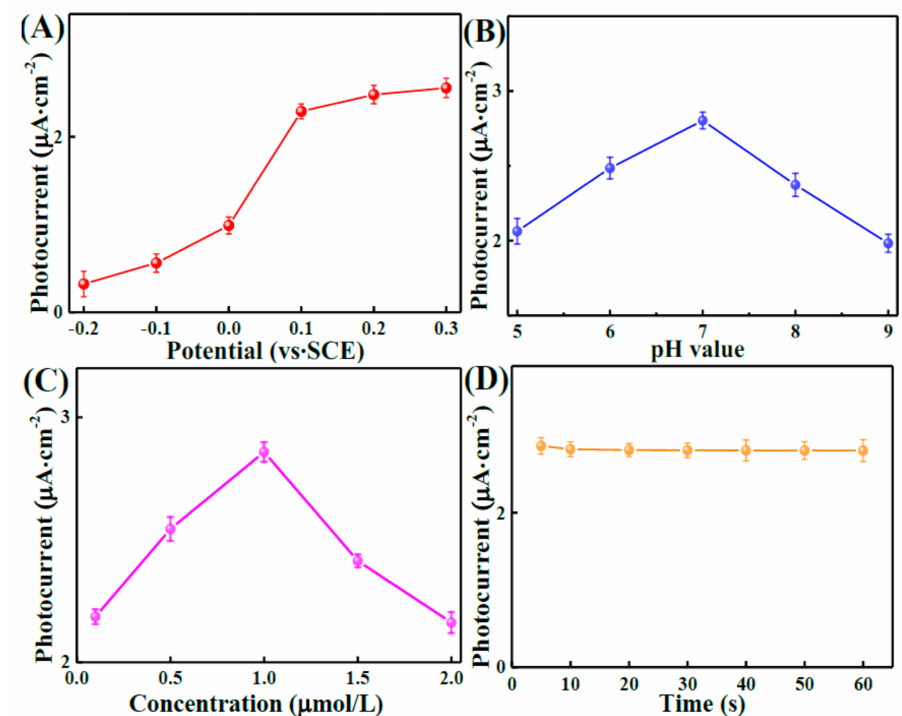
Figure 6. Photocurrent of aptamer/MoS 2 /LDH-5% at different potentials ( A ) and PH ( B ). Influences of aptamer concentration ( C ) and binding time of BPA ( D ) on photocurrent of the aptamer/MoS 2 /LDH- 5% toward BPA in PBS (pH = 7.0) containing 0. 1 mol L − 1 AA, under visible-light